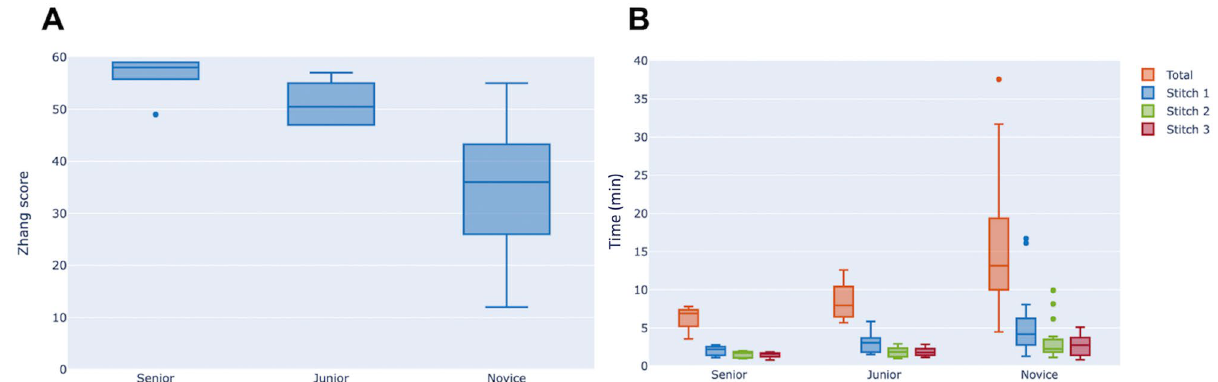
Figure 1. Box-and-whisker plot representing stitch quality assessment score (Zhang score) ( A ) and time analysis ( B ) for the three groups of the study (medians and interquartile ranges). ( A ) Zhang score significantly increased in more experienced groups (novice group < junior group < senior group; p < 0.001). ( B ) Total time with penalties to perform three corneal stitches (orange), time taken to perform the first (blue) and second (green) stitch significantly decreased in more experienced groups (p = 0.002, p = 0.013 and p = 0.032, respectively). Time to perform the third stitch (red) did not differ between groups. Data are represented as medians and interquartile